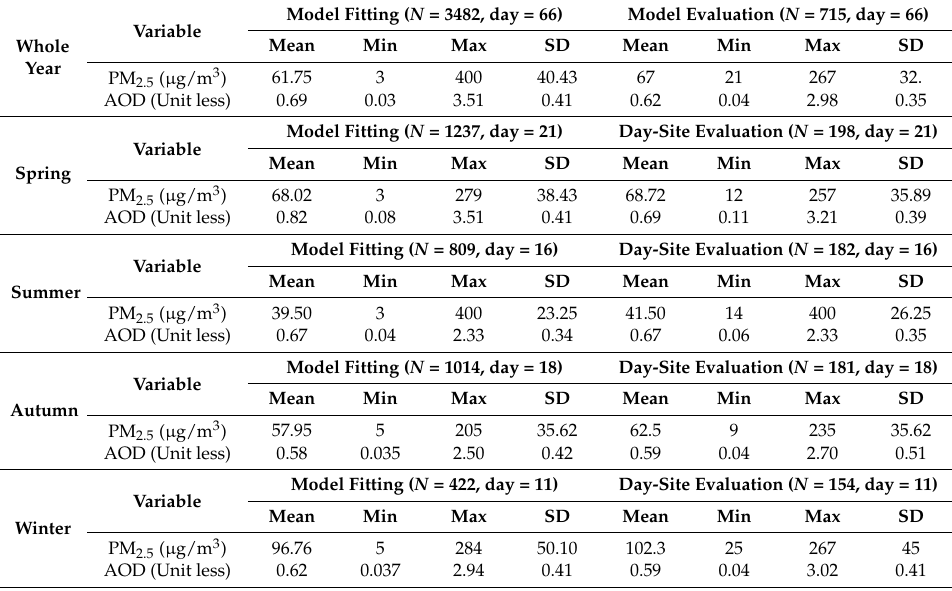
Table 3. Description statistics of PM 2.5 and Aerosol Optical Depth (AOD) for GWR model fitting and